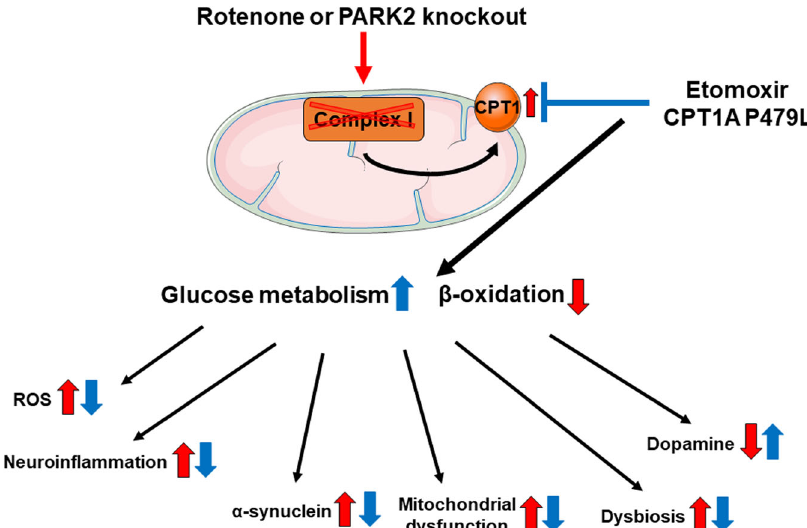
Fig. 10 Inhibition of CPT1 counteracts rotenone-induced pathological mechanisms by targeting both extra- and intracerebral systems. Rotenone or PARK2 knockout results in blockade of mitochondrial complex I and upregulation of CPT1 and thereby β -oxidation. The upregulation of CPT1(A) is attenuated by the pharmacological antagonist etomoxir and the hypomorphic CPT1A allele (P479L mutation). Upregulation of CPT1 results in extracerebral effects such as the production of reactive oxidative species, production of pro-in fl ammatory cytokines, disruption of mitochondrial homeostasis and dysbiosis in the gut. Furthermore, this upregulation exacerbates intracerebral pathological mechanisms such as neuroin fl ammation, oxidative stress, aggregation of α -synuclein oligomers, mitochondrial dysfunction, which results in dopamine loss due to the death of dopaminergic neurons. Inhibition of CPT1(A) causes a shift toward glucose metabolism, causing amelioration of these disease